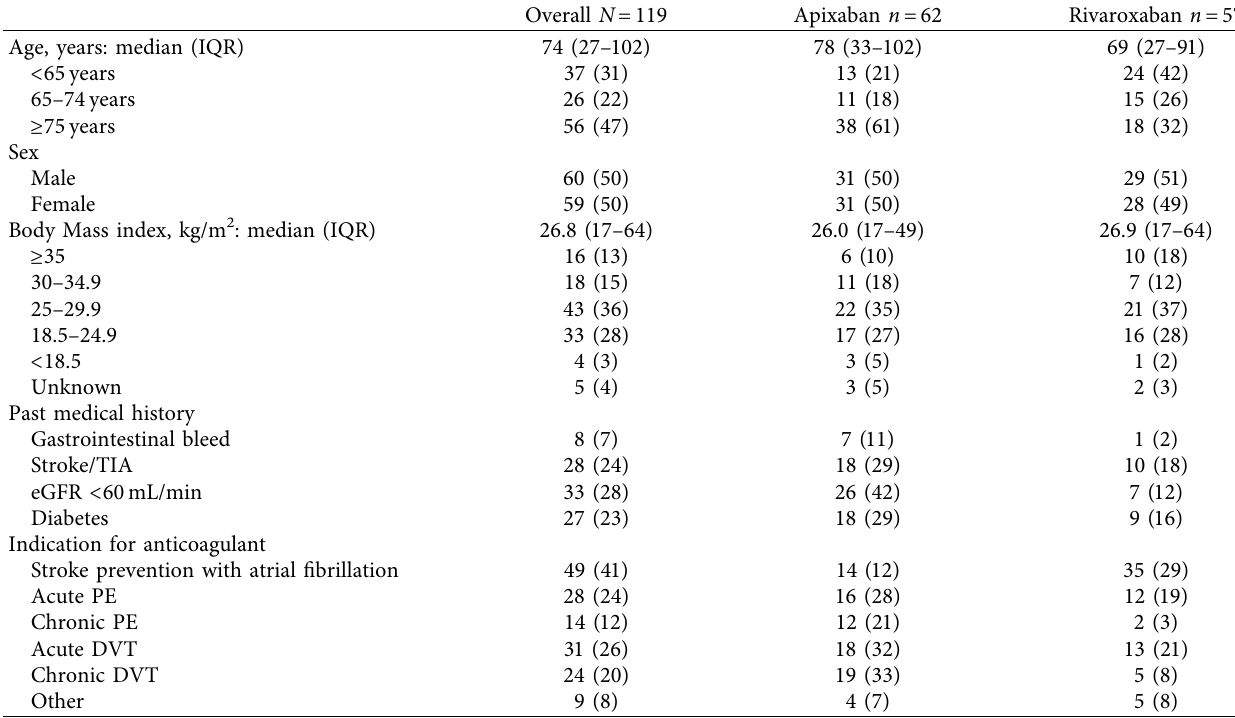
Table 1: Patient baseline characteristics.